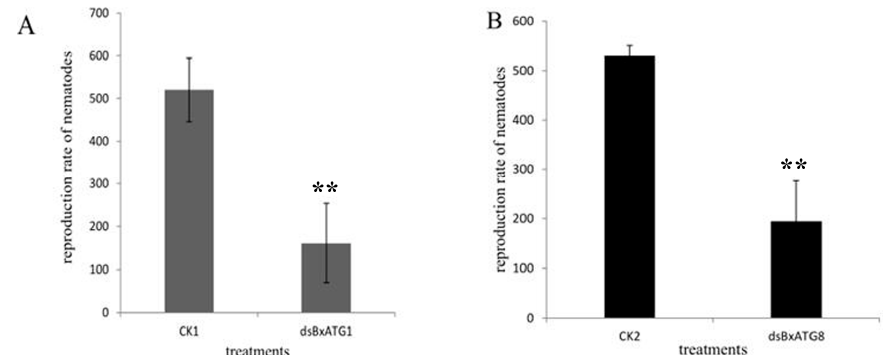
Figure 6. Effect of RNAi on B. xylophilus reproduction. Reproduction rates of B. xylophilus washed from potato dextrose agar (PDA) plates of B. cinerea with ds BxATG1 and ds BxATG8 and CK1 and CK2, respectively. Data represent mean values ± SD from three independent experiments. Bars show standard deviations of the mean. Asterisks on top of the bars indicate statistically significant differences between the ds BxATG1 ( A ) and ds BxATG8 ( B ) nematodes and controls (** p < 0.01, Student’s t -test).